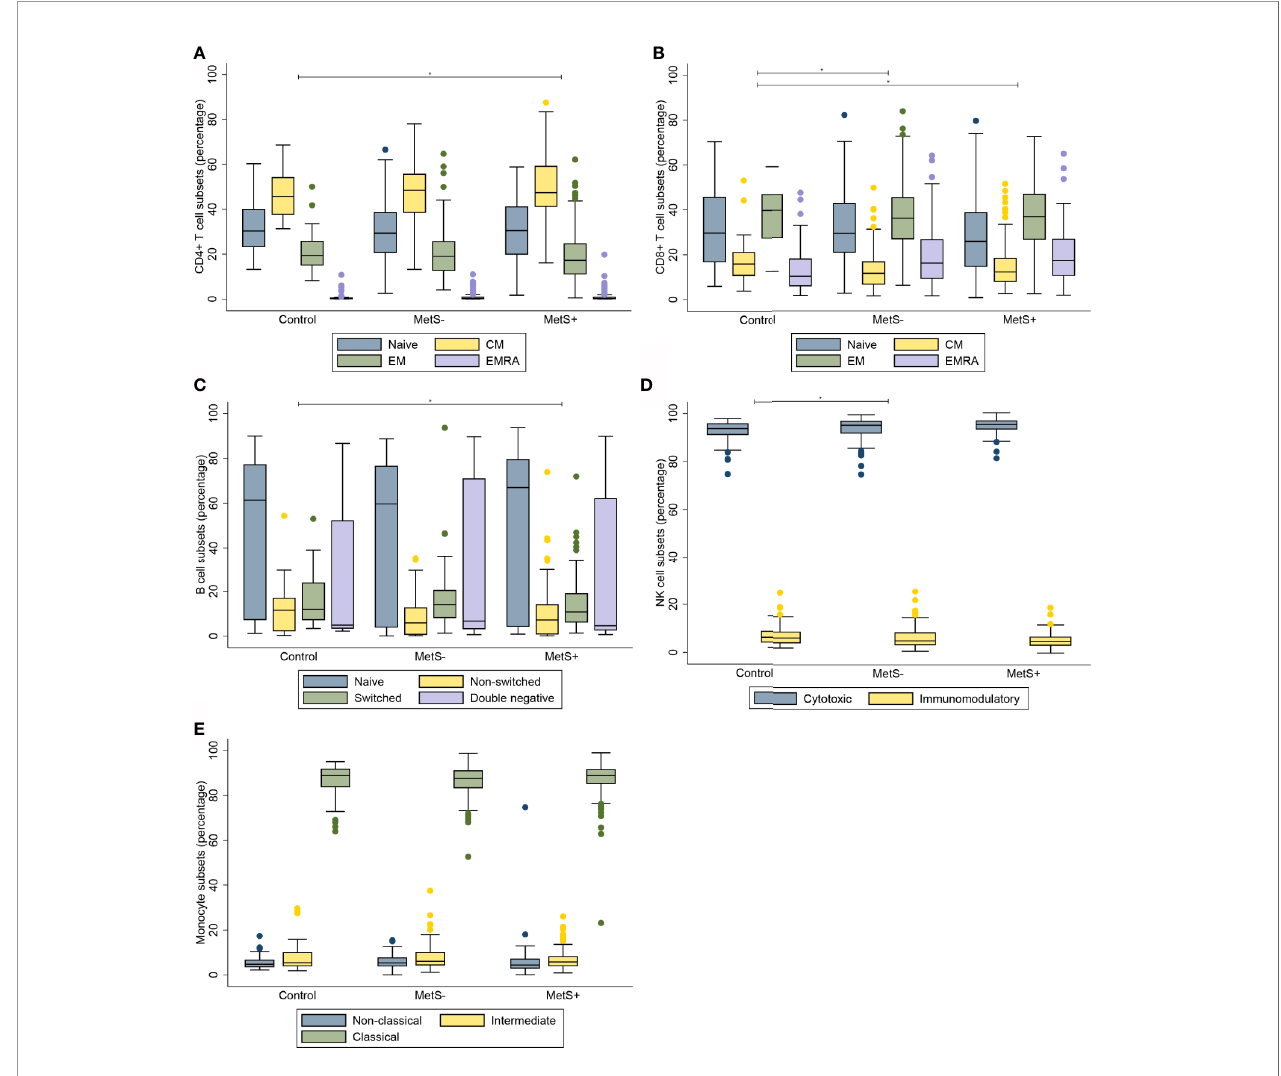
FIGURE 1 | Composition of immune cell subsets in absolute cell counts. (A) CD4+ T cell subsets. (B) CD8+ T cell subsets. (C) B cell subsets. (D) NK cell subsets. (E) Monocyte subsets. MetS-, morbidly obese patients without metabolic syndrome; MetS+, morbidly obese patients with metabolic syndrome; CM, central memory; EM, effector memory; EMRA, terminally differentiated effector memory. * P <